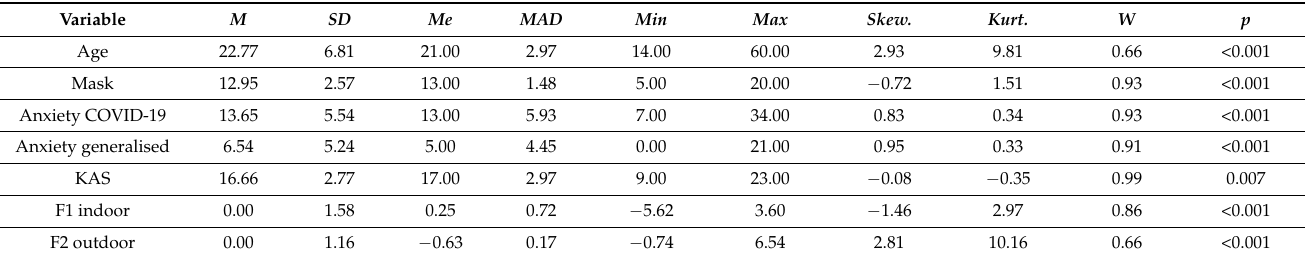
Table 3. Descriptive statistics analysis.